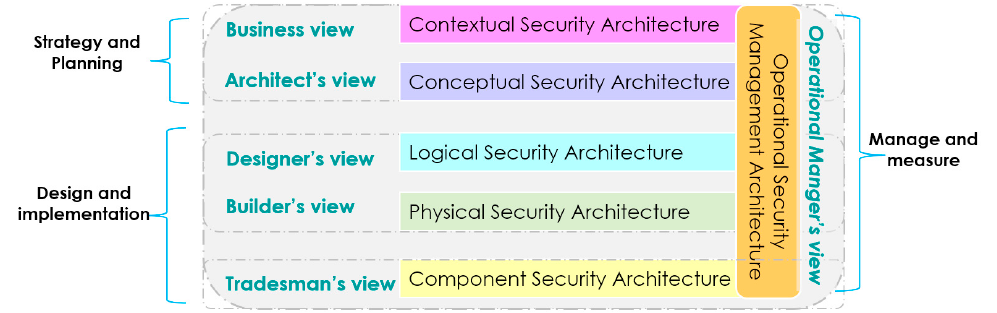
Figure 10. The SABSA